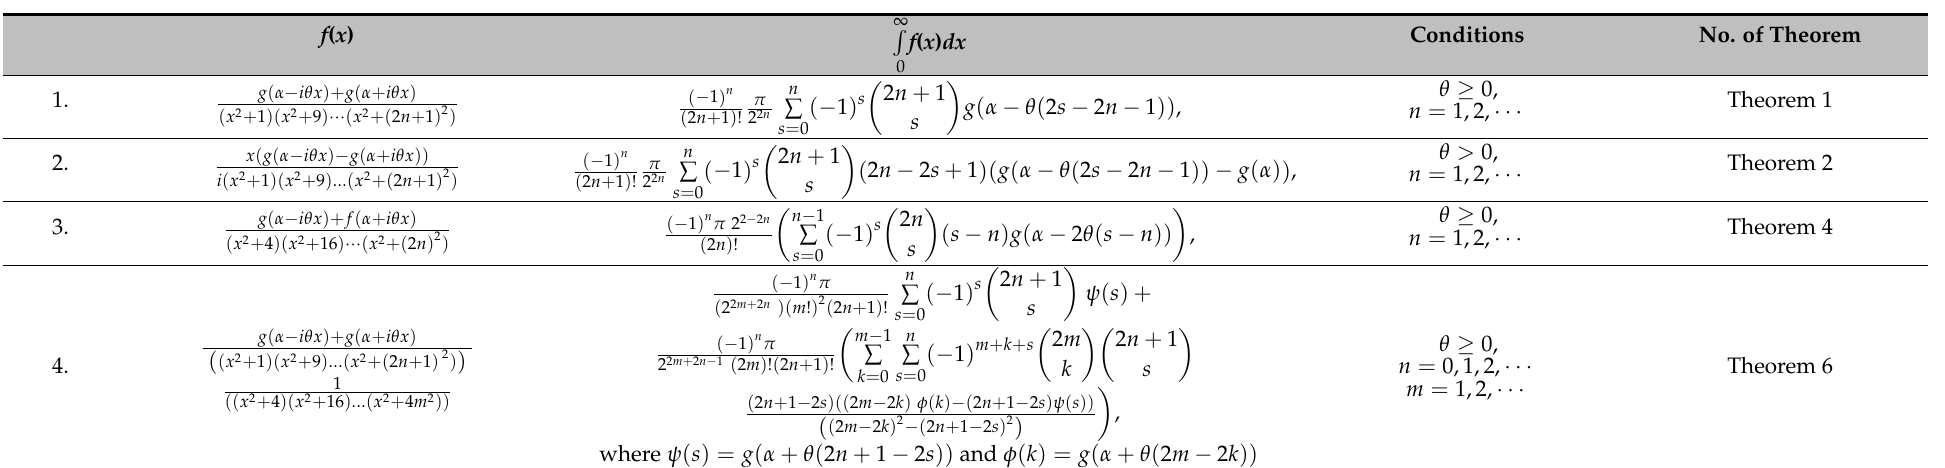
Table 1. Improper integral formulas with the series representation as detailed in Equation